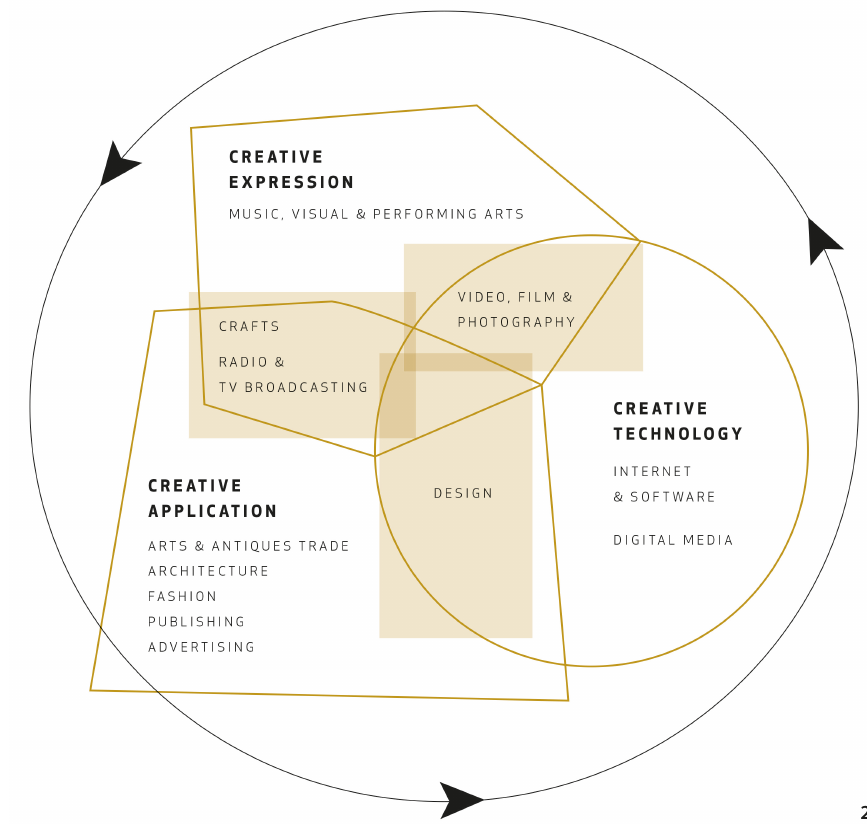
Figure 2 Rural creative industries by sectors and broad categories (Source: WDC